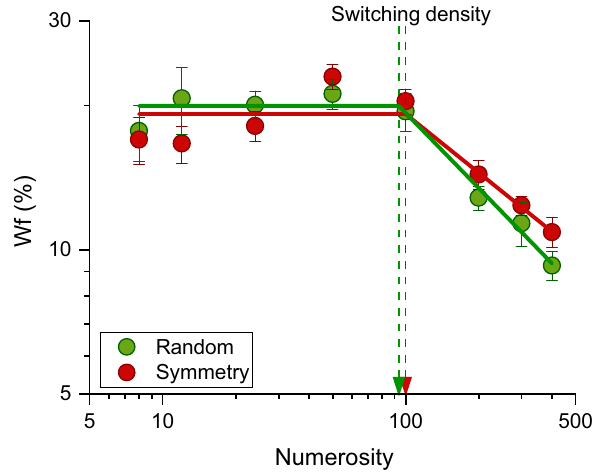
Figure 2. Average Wf (JND normalized by physical numerosity), as a function of numerosity for the random (green dots) and symmetry (red dots) conditions. Continuous lines are two-limb linear functions that best fit the data (Eq. 2). Arrows indicate the switching point from the estimation to the density regime for random (green arrow) and symmetry (red arrow) condition, respectively. Error bars represent ± 1